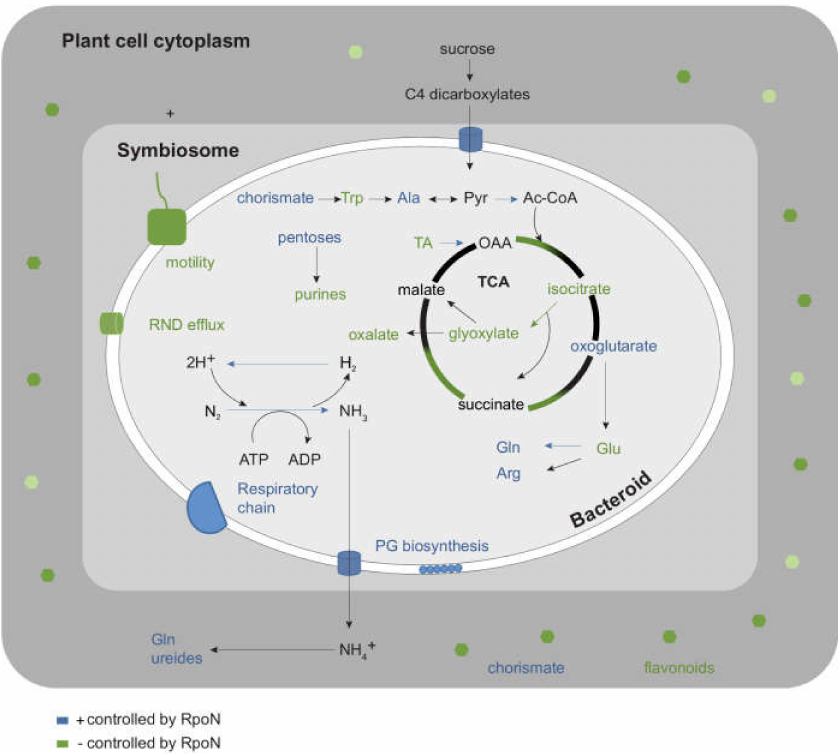
Figure 6. Scheme of the main changes in metabolites and transcripts profile in P. vulgaris root nodules infected by a rpoN mutant, compared to wild-type nodules. Metabolites and reactions down- and up-regulated in nodules induced by the rpoN mutant are indicated in blue and green, respectively.